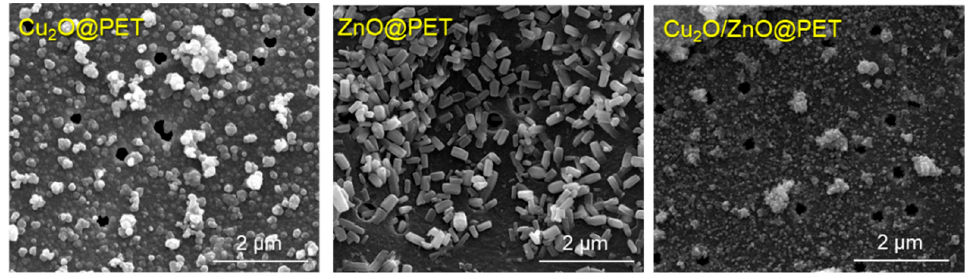
Figure 1. SEM images of the surfaces of synthesized